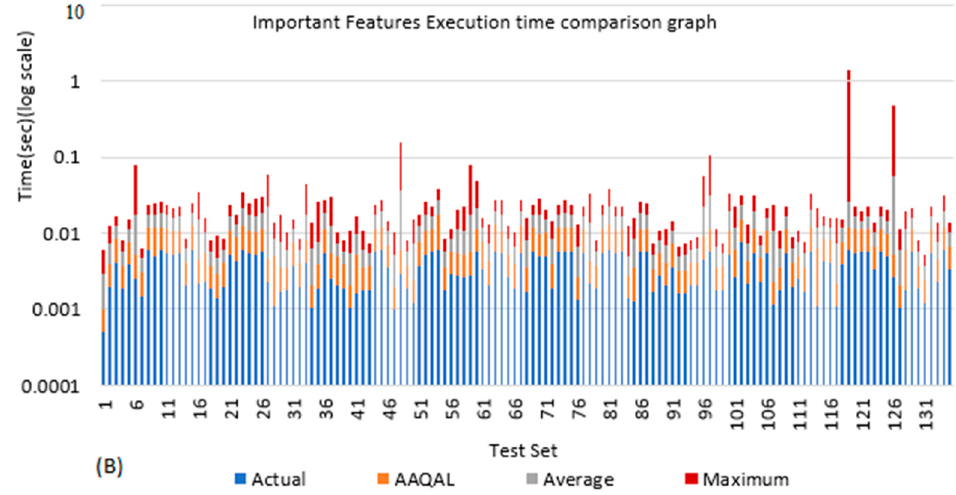
Figure 17. Performance gain random forest with important features ( A ) and execution time comparison ( B ) with important features (test